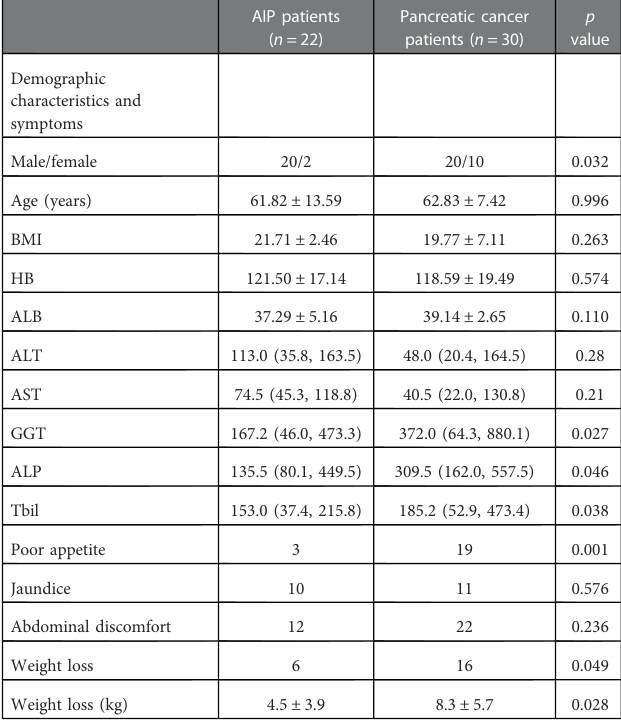
TABLE 1 Demographic characteristics and symptoms of AIP patients and pancreatic cancer